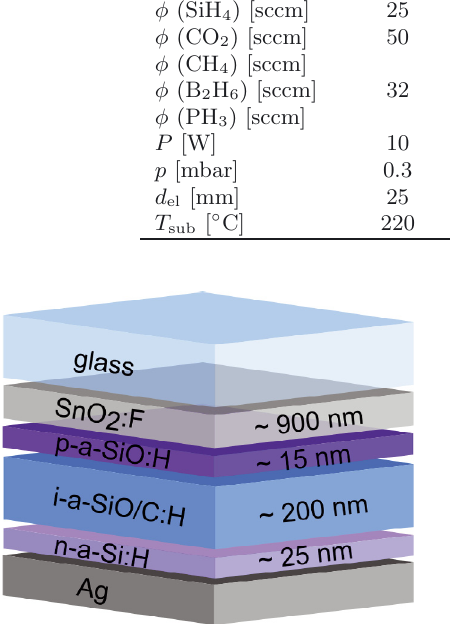
Fig. 1. Layer stack of a-SiO:H and a-SiC:H single